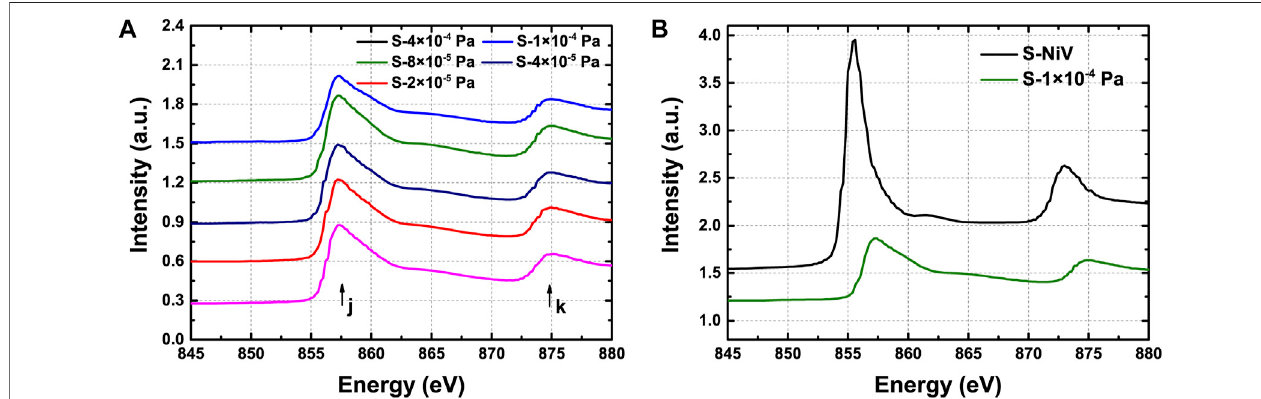
FIGURE 6 | The nickel (Ni) L-edge XANES spectra of different samples. (A) NiV/B 4 C MLs deposited with different background pressures (S-4 × 10 − 4 , S-1 × 10 − 4 , S-8 × 10 − 5 , S-4 × 10 − 5 , and S-2 × 10 − 5 Pa). (B) NiV/B 4 C ML and NiV coating both deposited with 1 × 10 − 4 Pa.